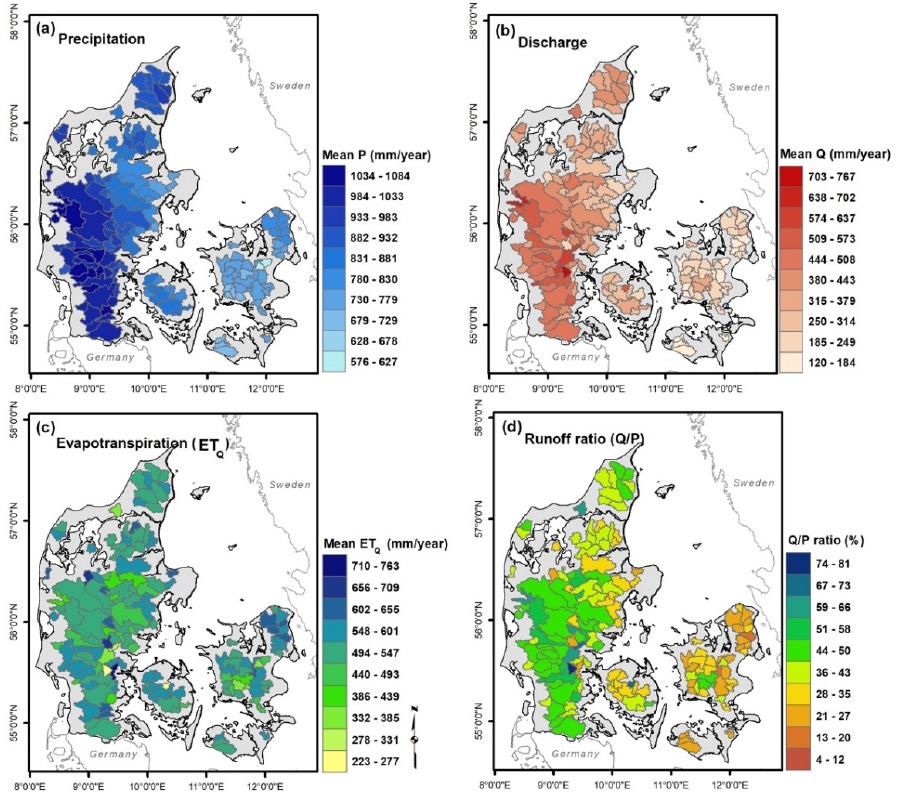
Figure A2. The catchment-based annual mean maps: ( a ) observed precipitation, ( b ) measured su face streamflow, ( c ) water balance evapotranspiration, and ( d ) the runoff ratio map (discharge/pre- cipitation).